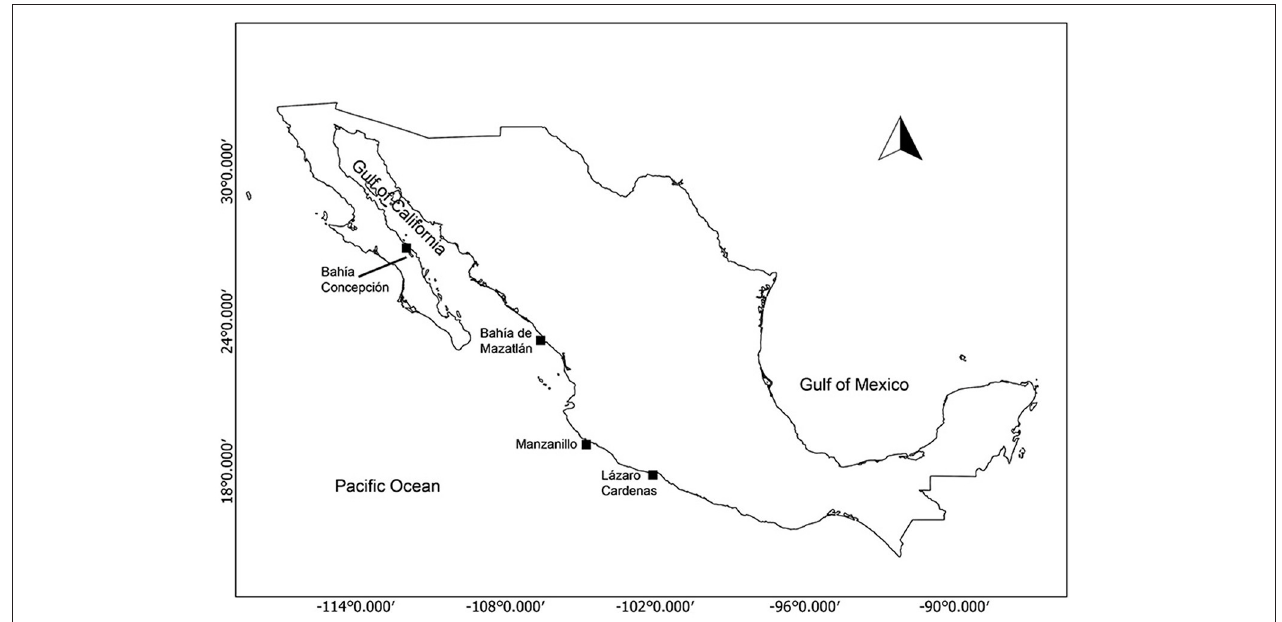
TABLE 1 | Strains, place and year of isolation, and GenBank accession number of the Mexican Gymnodinium catenatum . Strain Place and date of isolation Isolator GenBank accession number